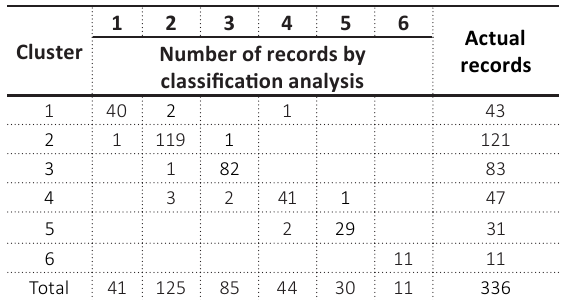
Table 4. Reliability of classification analysis